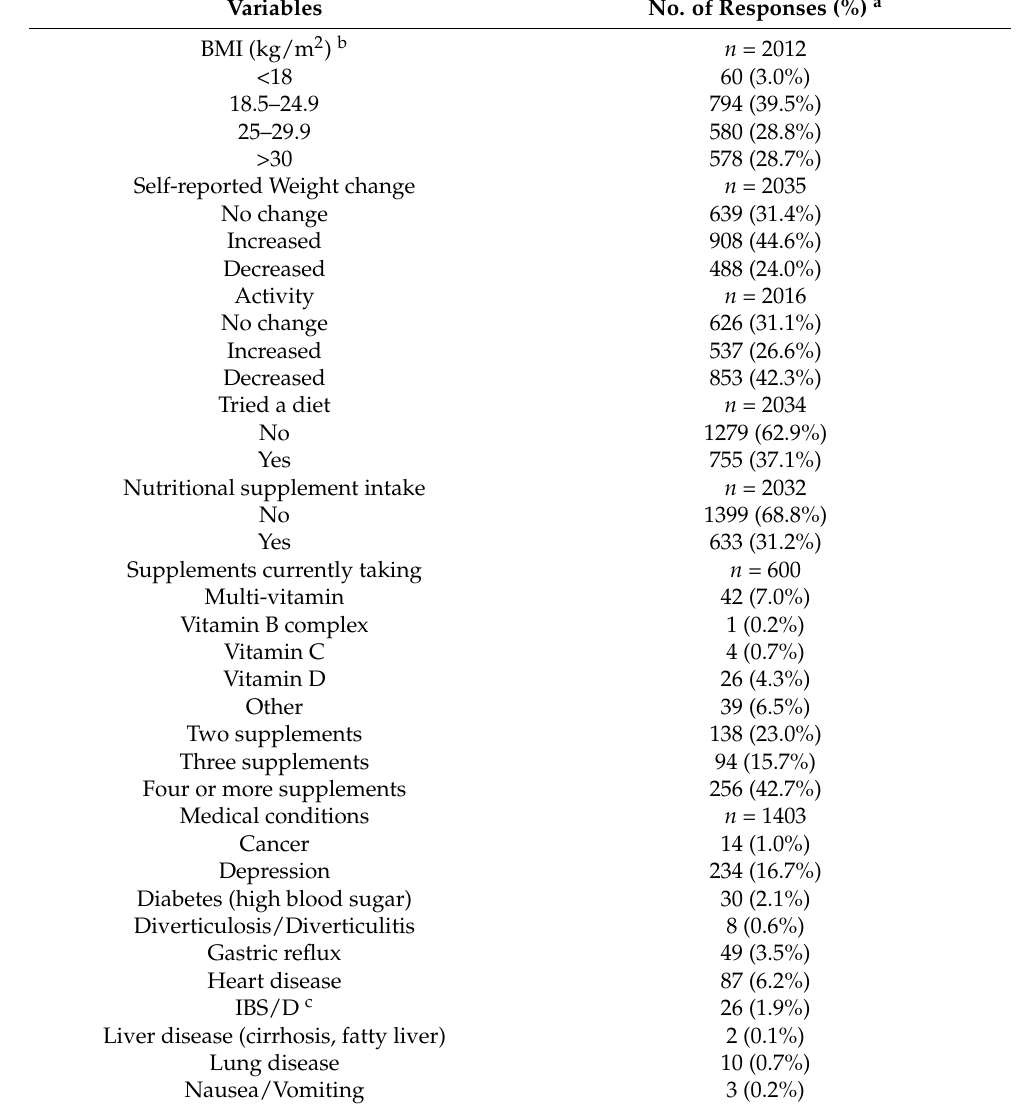
Table 3. Participants’ general health characteristics and